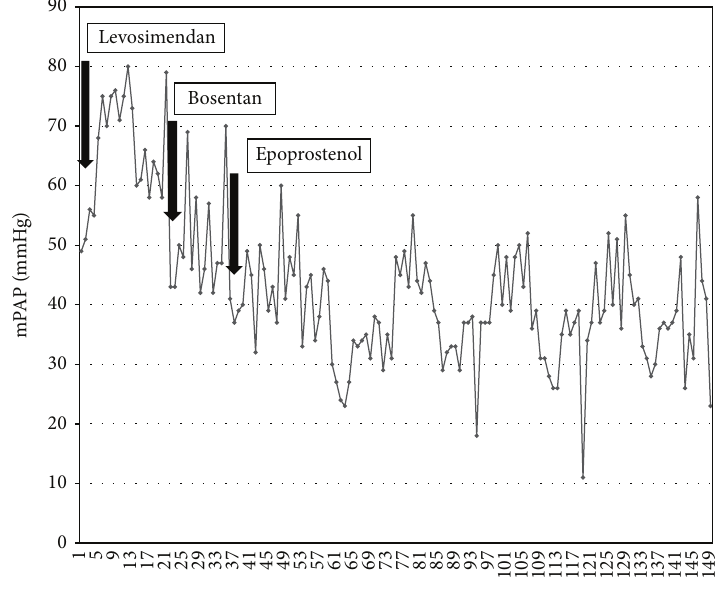
Figure 2: Original recording of invasively measured mean pulmonary artery pressures on ICU (days 1–5) and initiation of administration of levosimendan, bosentan, and